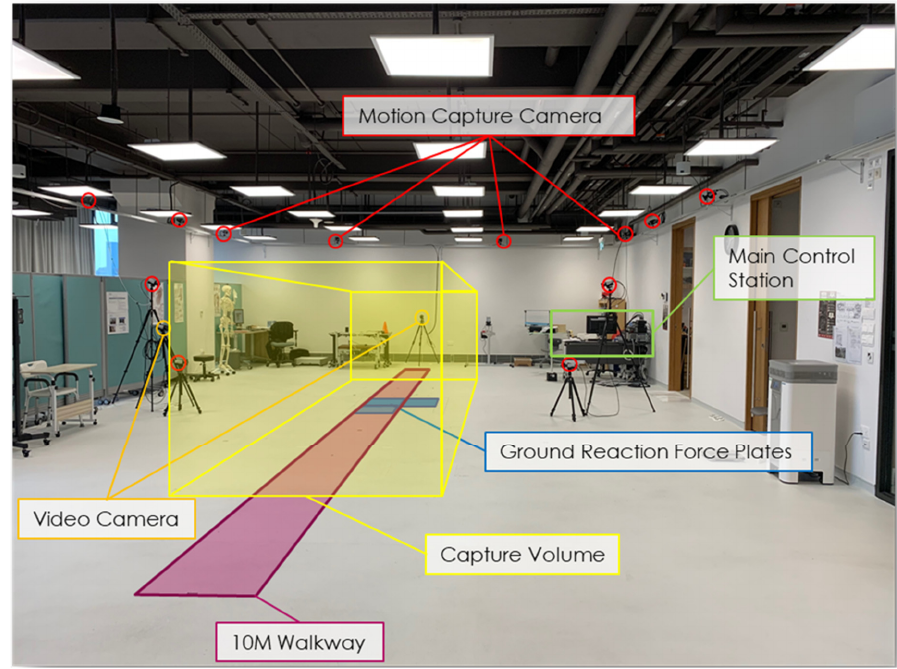
Figure 1. MOCAP laboratory.